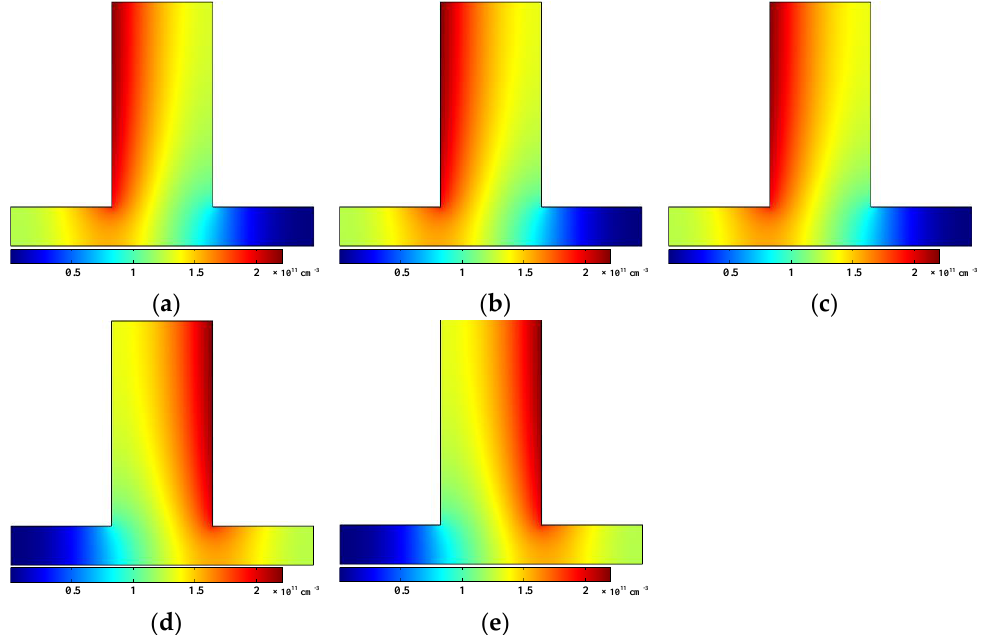
Figure 15. Spatial distribution of the O density for times ( a ) 2 ms, ( b ) 6 ms, ( c ) 10 ms, ( d ) 14 ms, and ( e ) 18 ms for the reactor at AC 22 kV voltage and 1 cm distance between electrodes.